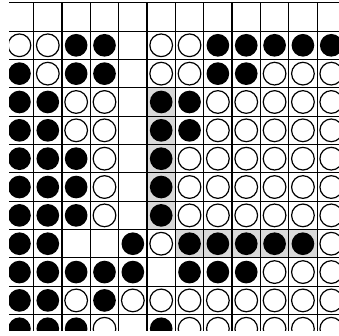
Figure 60. WHITE